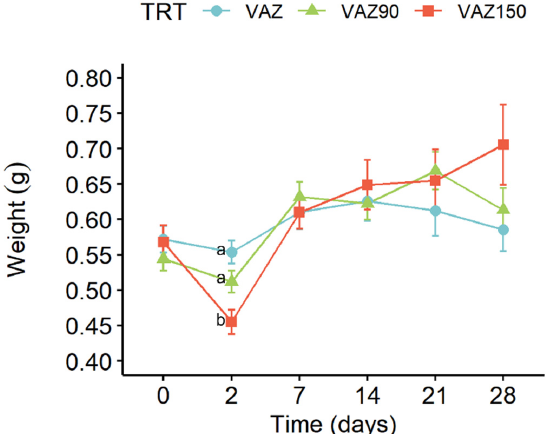
Figure 9. Earthworm's mean weight trend during the ecotoxicology test. According to Dunn’s multiple comparisons (Benjamini–Hochberg p -value adjustment, α -level = 0.05), different letters at the same time indicate significant differences between the treatments. When no letter is shown, there are no significant differences between treatments.